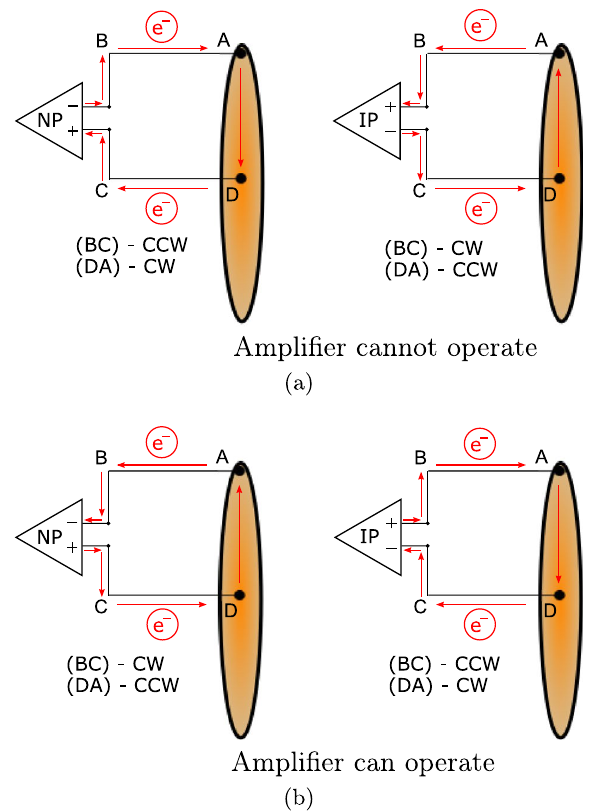
Figure 5. The electron flow in circuit ABCDA determines the operation of the amplifier, which in turn depends on the polarisation of the disc (DA) or closing wire (BC) due to the rotational direction in the magnetic field: ( a ) states in which the amplifiers cannot operate and no voltage can be observed; ( b ) states the amplifiers can operate in and a voltage can be